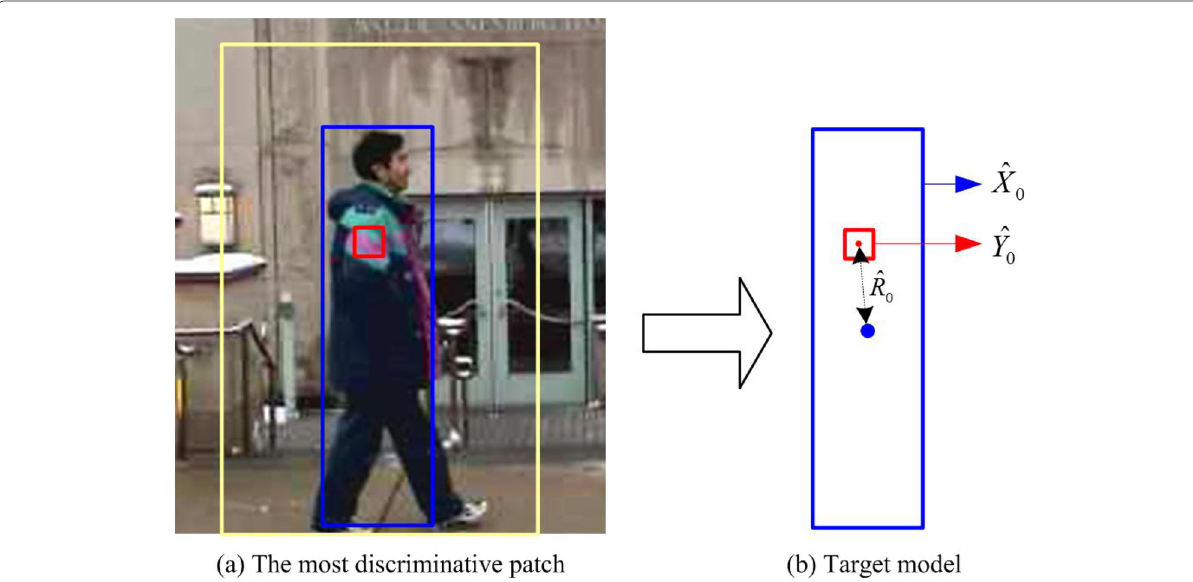
Fig. 1 Example of a target model on man sequence. a The selection result of the most discriminative patch, where the red square denote the patch and the blue rectangle indicates the target region whereas the yellow indicates local background. b The target model constructed base on the selected